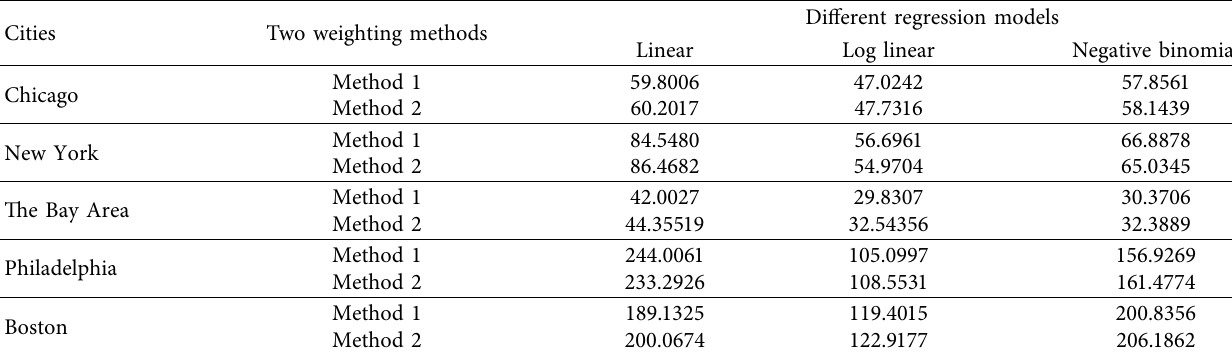
Table 15: Table of the MAPE of negative binomial regression model of two weighting methods in five